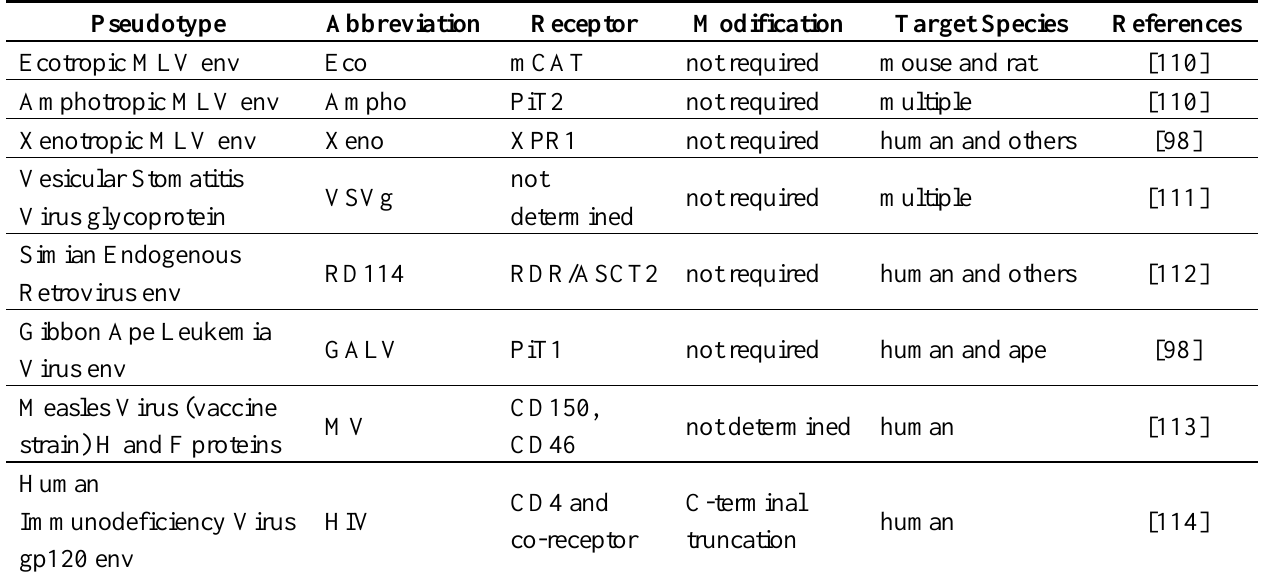
Table 1. List of most important pseudotypes, their receptors and envelope modifications required for pseudotyping of MLV to transduce certain target cells /